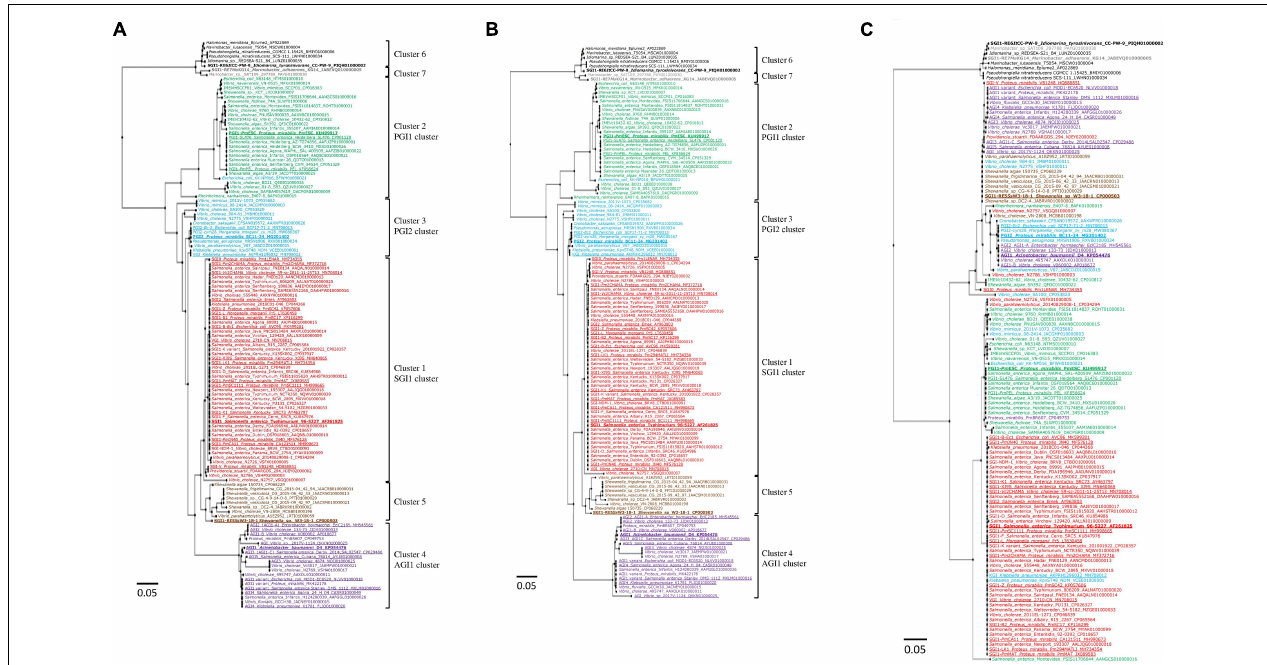
FIGURE 2 | Phylogenetic tree of the backbones of SGI1-REs. (A) Complete backbones. (B) First part of the backbones ( attL-oriT segment). (C) Second part of the backbones ( oriT-attR segment). The colors of the strains correspond to the clusters of SGI1-REs: red (cluster1: SGI1 cluster), green (cluster 2: PGI1 cluster),